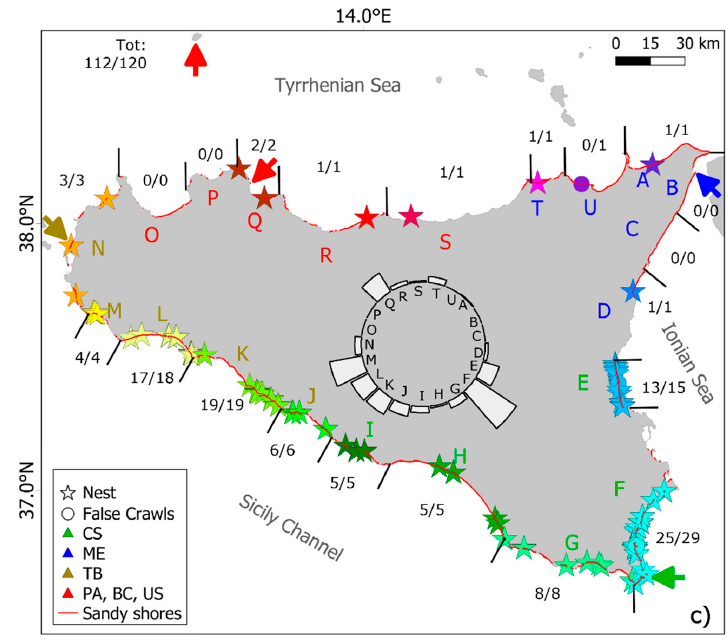
Figure 1. Sea turtle emergences reported in Sicily from 2017 to 2021 ( a ), 1944 to 2021 ( b ) and 1944 to 2016 ( c ), divided in Nests (stars) and False crawls (circles). Black lines perpendicular to the perimeter of the island indicate the 21 Physiographic Units (PU) identified by letters. The number of nests and the total number of emergences (nests + false crawls) are provided for each PU (in the form nests/emergences) and the totals are given in the top left of the figure. PUs letters are color coded with the Temperature Stations (arrows; Trapani Birgi: TB, Palermo: PA, Ustica Island: US, Boccadifalco: BC, Messina: ME, Capo Rizzuto: CR) that originated the data that were used to calculate IPMT. The circular plot in the middle provides mean annual nest density (nests km-1 year-1) for each PU.